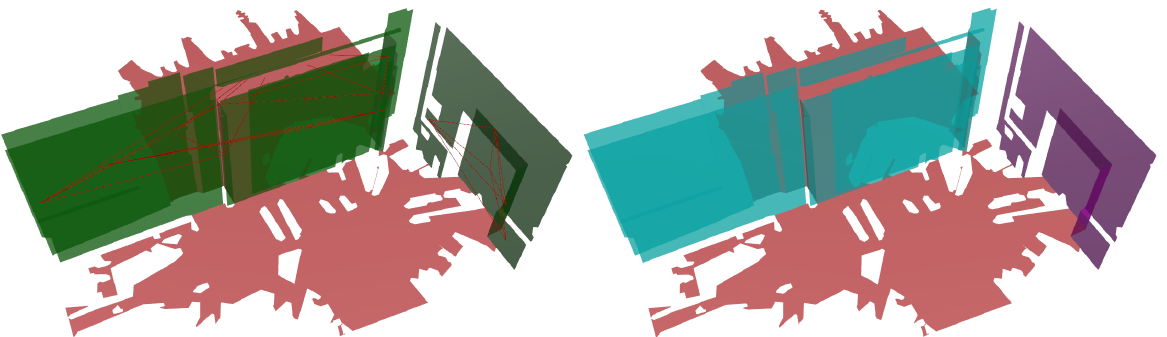
(c) Representation of the remaining edges after passing the edge validation criterium based on the intersections with the partial room information.